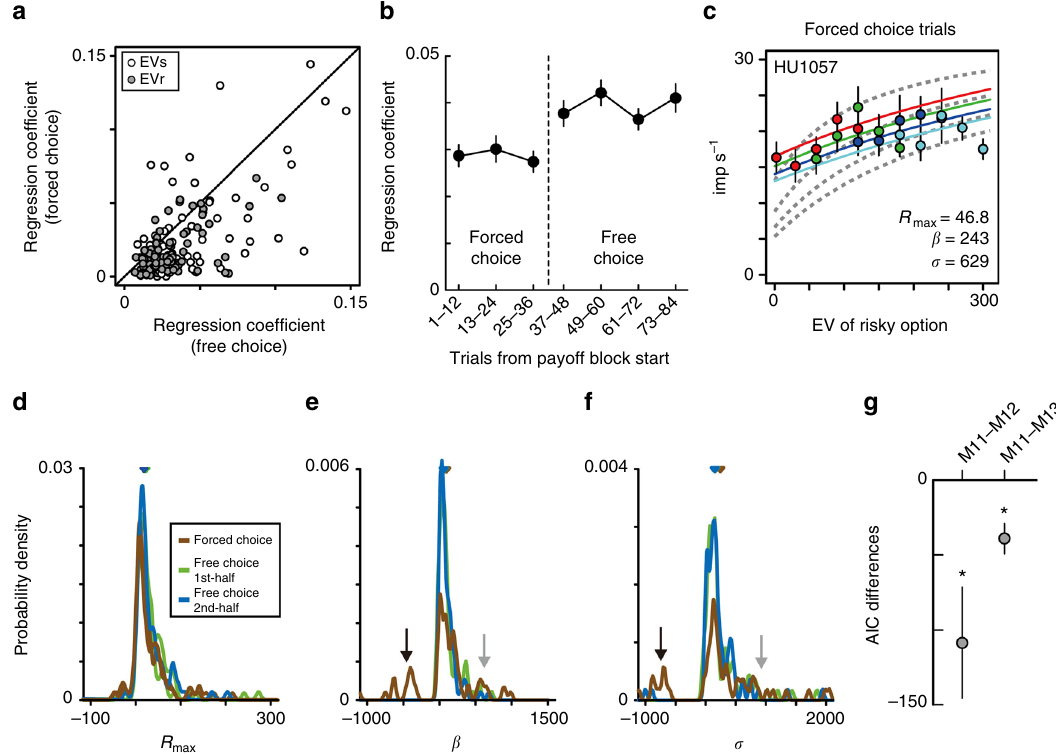
Fig. 7 Attenuated value coding of mOFC neurons during forced choice trials. a Plots of the absolute value of regression coef fi cients for EVr (gray) and EVs (white) during free and forced choice trials. Mean ± s.e.m. during free and forced choice trials: EVr, 0.031 ± 0.002, free choice, 0.017 ± 0.002, forced choice; EVs, 0.042 ± 0.003, free choice, 0.027 ± 0.003, forced choice. b Average of the absolute value of regression coef fi cients for EVr and EVs across the trial block. Regression coef fi cients were estimated every 12 trials from the start of the payoff block. Error bars indicate s.e.m. c Activity plots of the same neuron in Fig. 4 during the forced choice trials. Color lines indicated the best- fi t lines during the forced choice trials. Gray lines indicated the best- fi t lines during the free choice trials as shown in Fig. 4a. d – f Probability density of the estimated parameters of the models during forced choice trials (brown), the 1st half of the free choice trials (green), and 2nd half of the free choice trials (blue). In d – f , triangles in the fi gures indicate the median. g Plots of the AIC differences between models estimated across the population. AIC differences between model 11 and models 12 – 13 are shown. Error bars indicate s.e.m. In a – g , the results during forced choice trials were shown when assuming expected values of risky and safe options were de fi ned as indicated by pie chart stimuli (assumption 1, see Methods for representing baseline fi ring rates in the normalization model 34 . activity, suggesting that the advanced fractional model may Across our population, R max β σ − 1 values were signi fi cantly underlie relative value signals in mOFC neurons. correlated with observed baseline fi ring rates before the cue stimuli appeared (Fig. 6e, n = 81, r = 0.41, P < 0.001, t = 4.00, df = 79). Thus, the estimated parameters of the normalization model Decision context and normalized value signals in mOFC . To appear to appropriately capture aspects of the observed neural further test whether a normalized value code is speci fi cally related